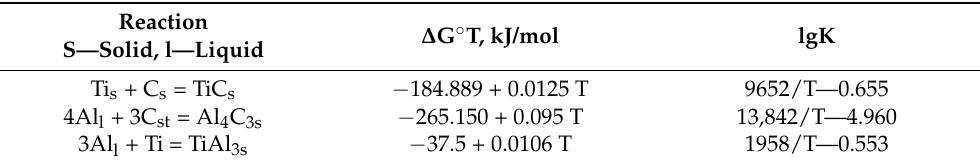
Table 1. Temperature dependence of Gibbs energy and equilibrium constants of the formation reaction of some phases in liquid aluminum